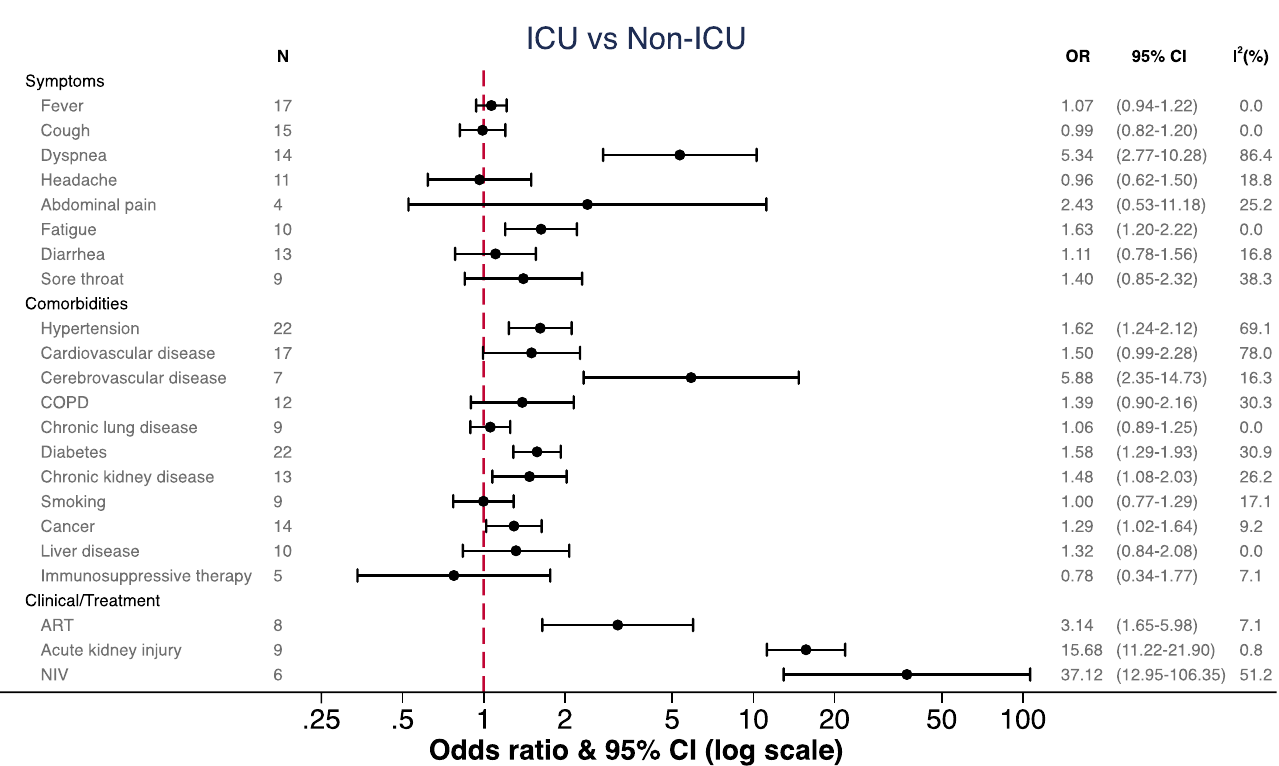
Fig 3. Pooled odds ratios among ICU vs. non ICU groups. ICU = Intensive care unit, OR = odds ratio, CI = confidence interval, COPD = chronic obstructive pulmonary disease, ART = anti-retroviral treatment, NIV = non-invasive ventilation.